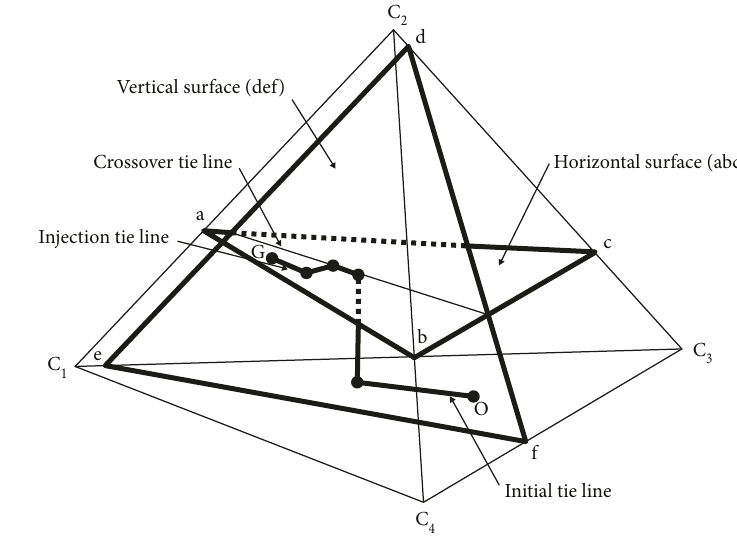
Figure 3: Quaternary system tie line.